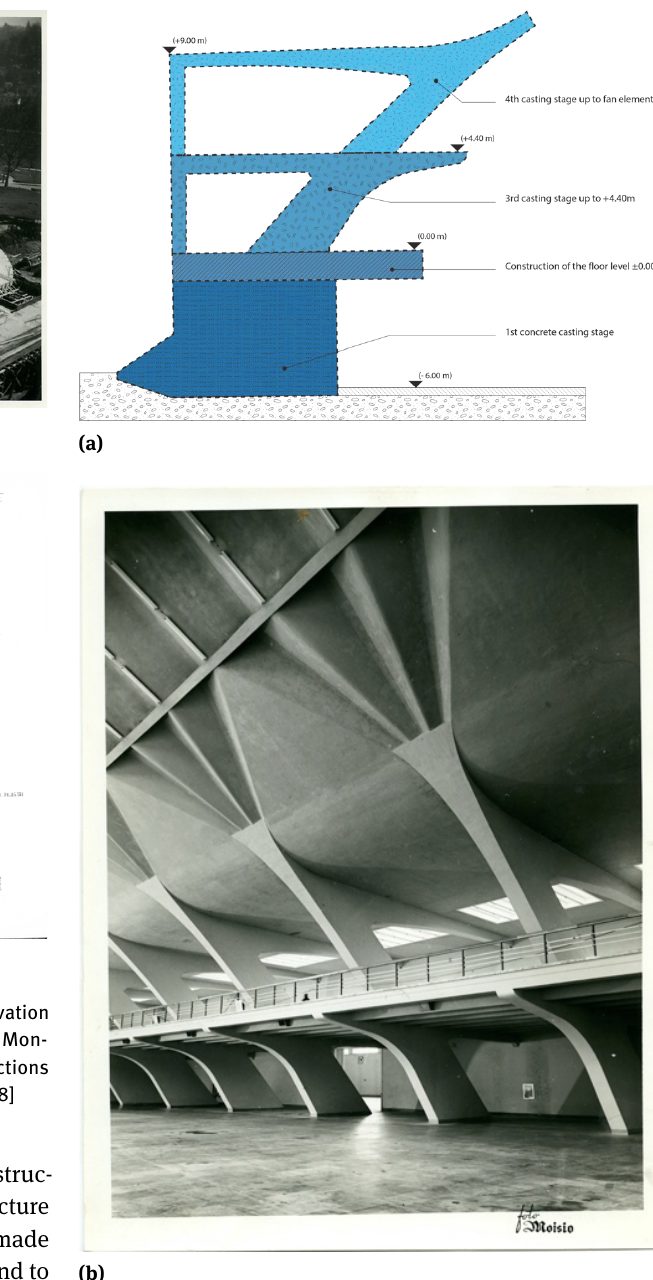
Figure 4: (a) Scheme of the various casting stages of pillars. (b) Detail of the interiors just after the completion of the hall (photo of Aldo Moisio)